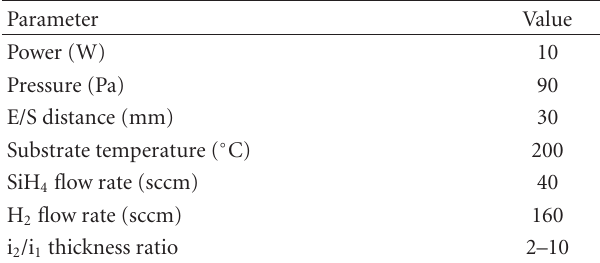
Table 1: The deposition conditions of intrinsic layer of the tandem solar